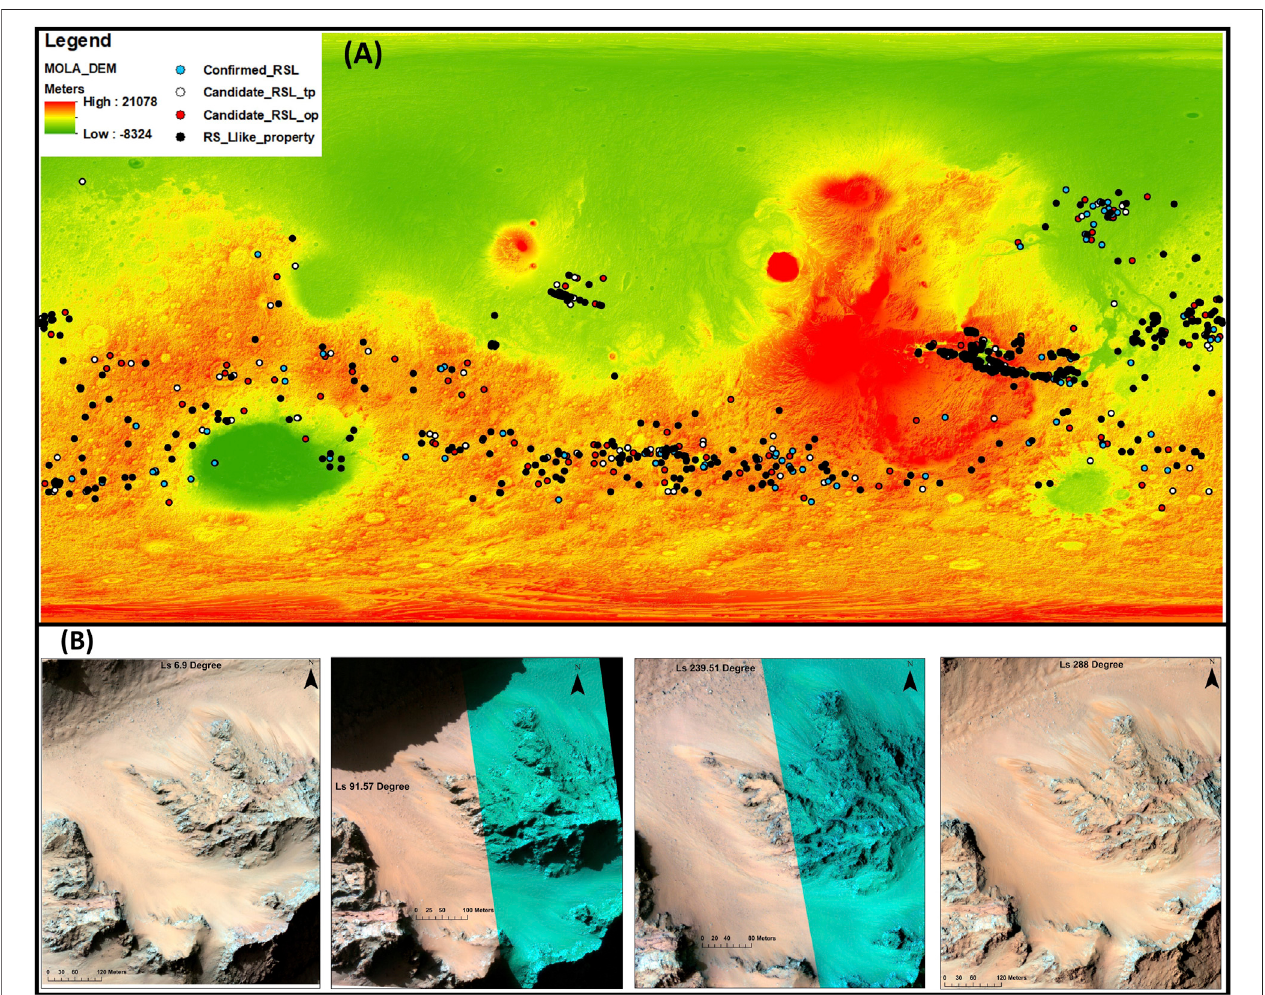
FIGURE 1 | (A) Updated RSL sites from previous literature (Stillman et al., 2014) and new identi fi ed sites globally on Mars. In legend, tp stands for RSL site having two properties of RSL, whereas op stands for site having one property of RSL, which are described as candidate RSL sites. (B) temporal observation of the con fi rmed RSL site in the